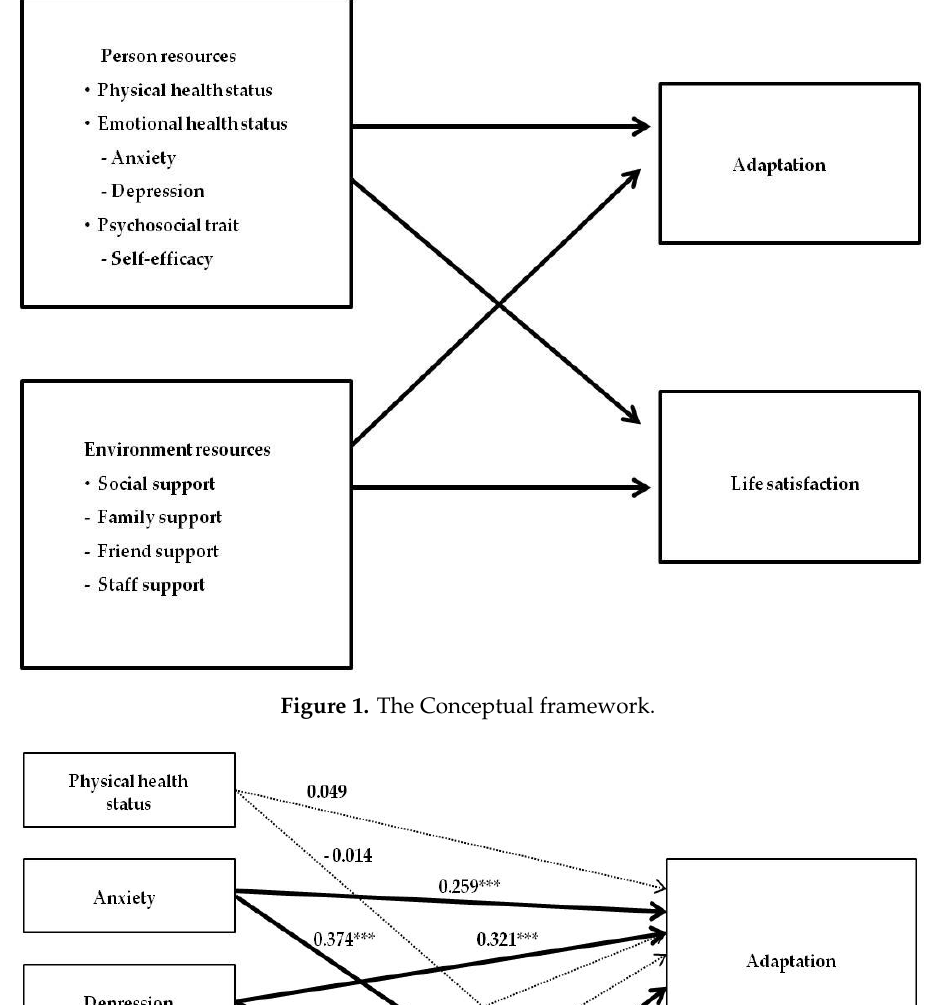
Figure 1. The Conceptual framework.